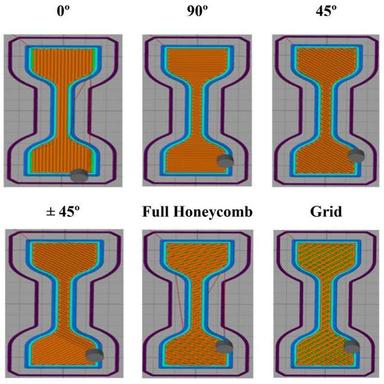
3D printing infill patterns.